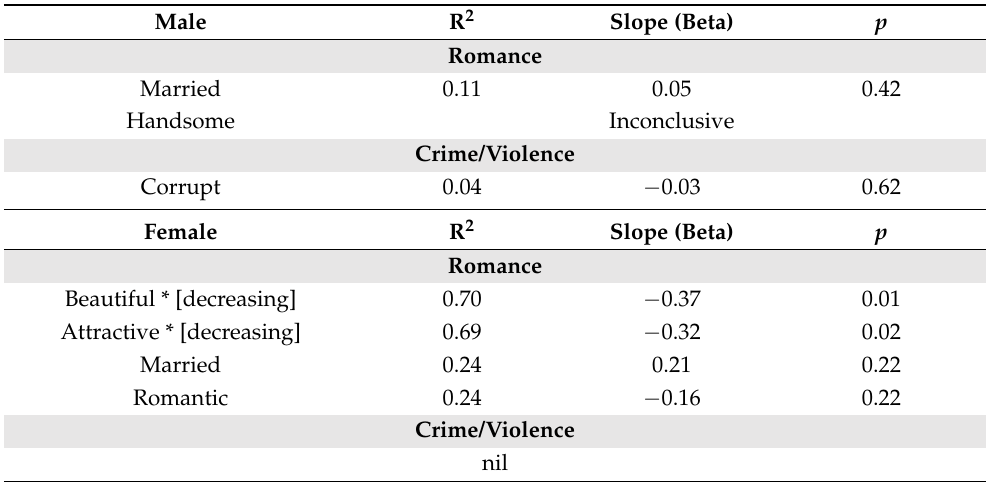
Figure 11. Most significant primary adjective associations with males and females. Adjectives found to strongly co-occur with female characters included ‘pregnant’ and ‘beautiful’; for male characters, they included ‘former’ and ‘best’, among others. Adjectives such as ‘young’ and ‘married’ co-occurred strongly with both female and male characters. Table 5. Linear regression analysis of edge weight regressed on decade for stereotypical adjectives. * p < 0.05.